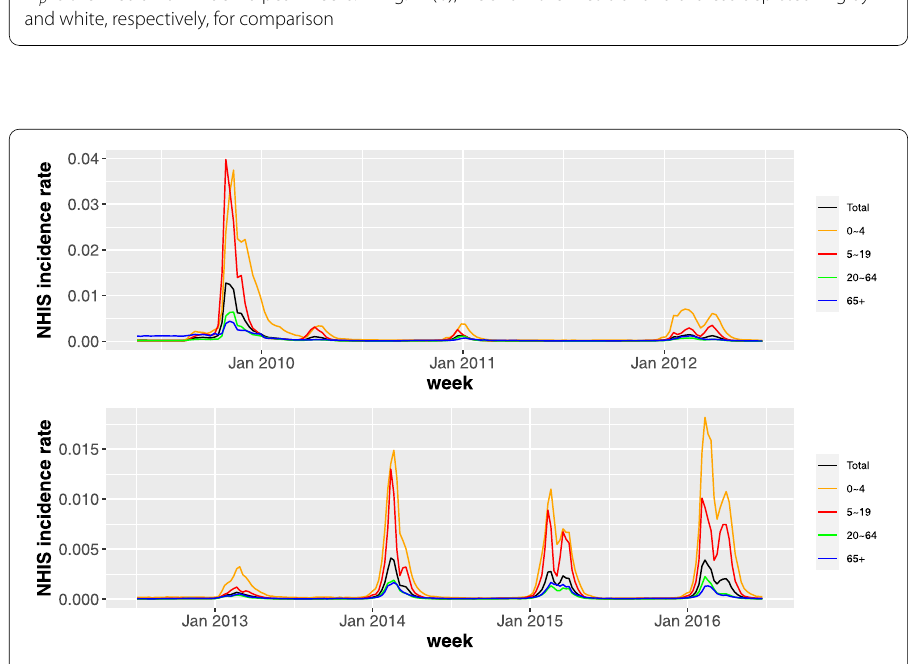
Figure 12 The incidence rate of influenza for each age-group in South Korea (2009–2016). We show the incidence rate of influenza, that is, the number of new patients within a week divided by the total number